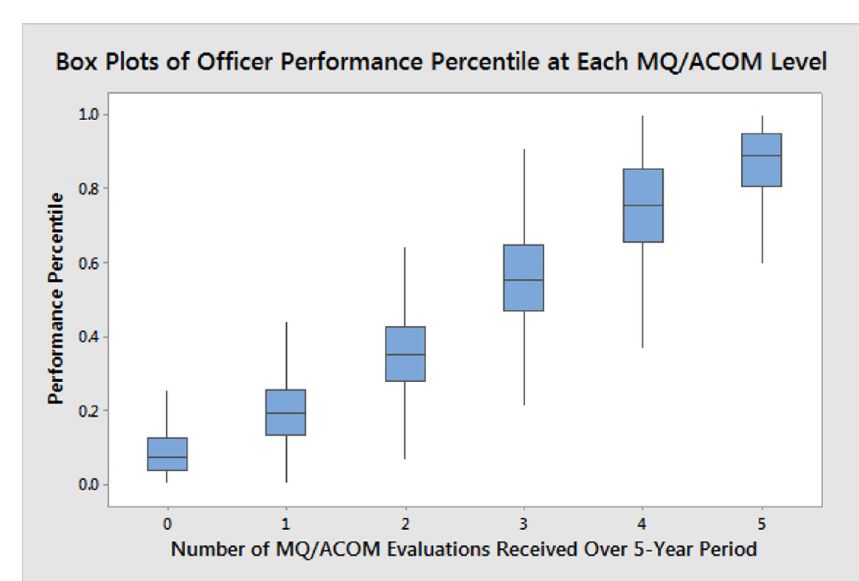
Table III. Sample of simulation output showing of fi cers with varying performance levels and the evaluations received